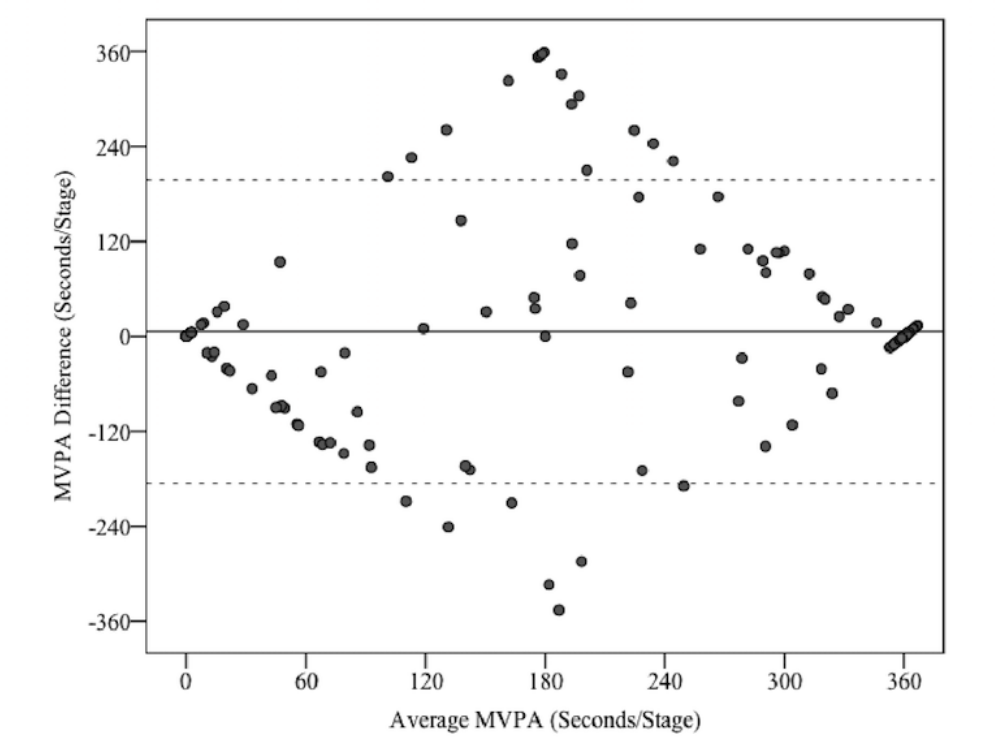
Figure 2. Bland-Altman plot analysis for indirect calorimetry and the height-adjusted PiezoRx-determined moderate-to-vigorous-intensity physical activity